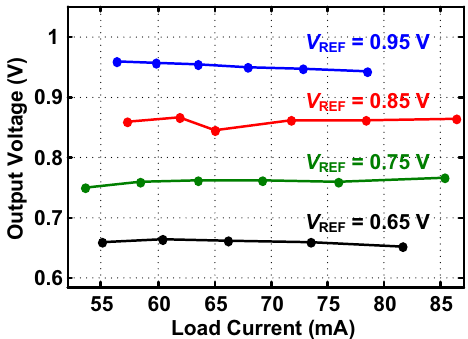
Figure 15. The output voltage under the variations of load